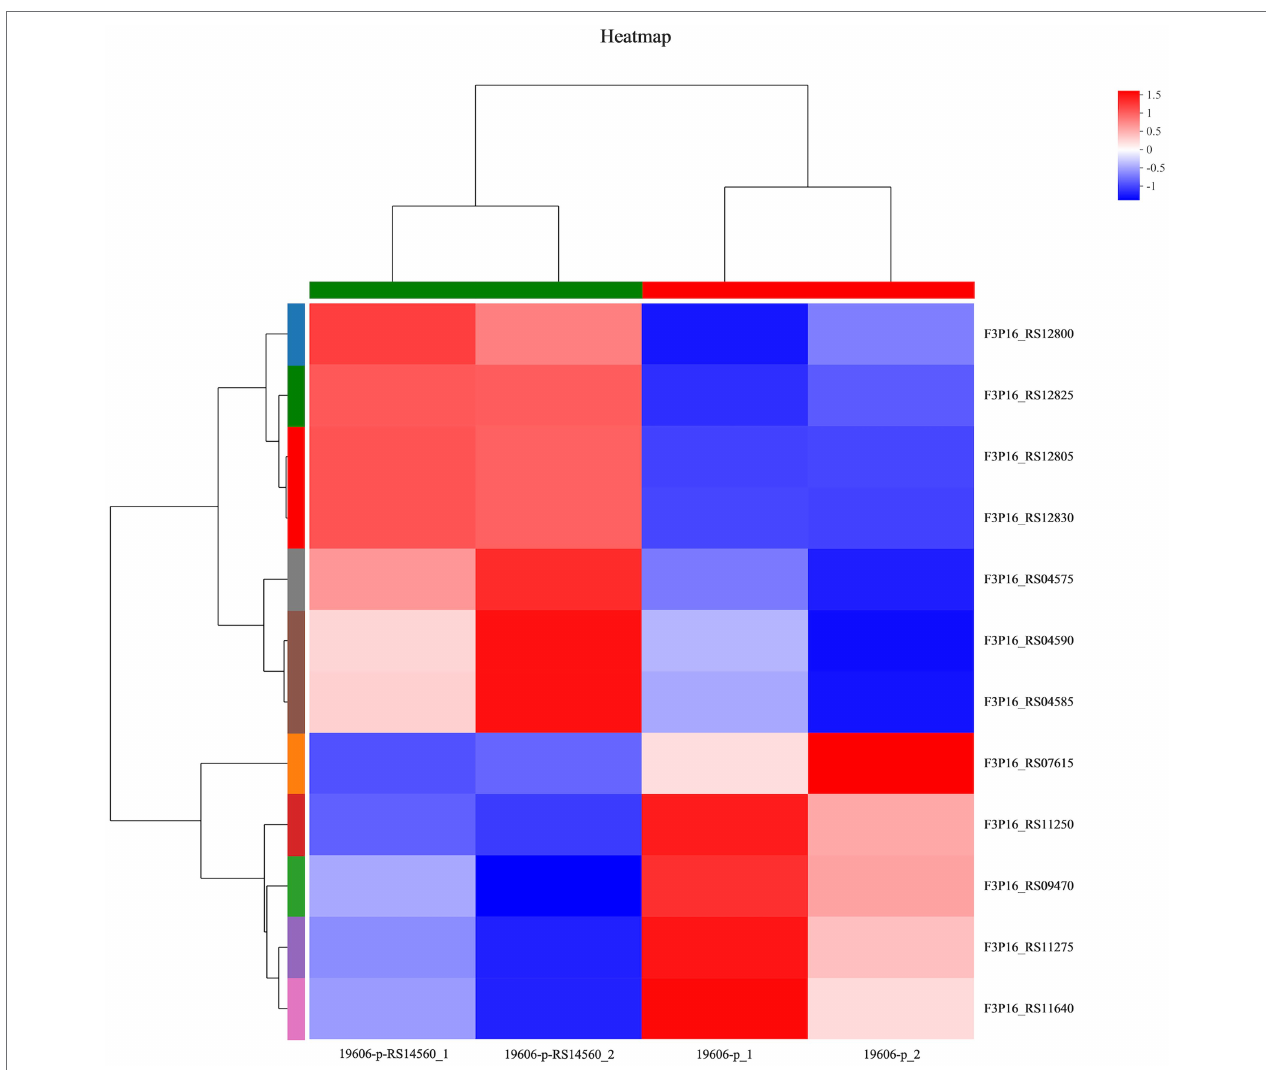
FIGURE 6 | Heatmap of differentially expressed genes. 19,606-p-RS14,560_1 and 19,606-p-RS14,560_2 represent the treated groups while 19,606-p_1 and 19,606-p_2 represent the control groups. FC, fold